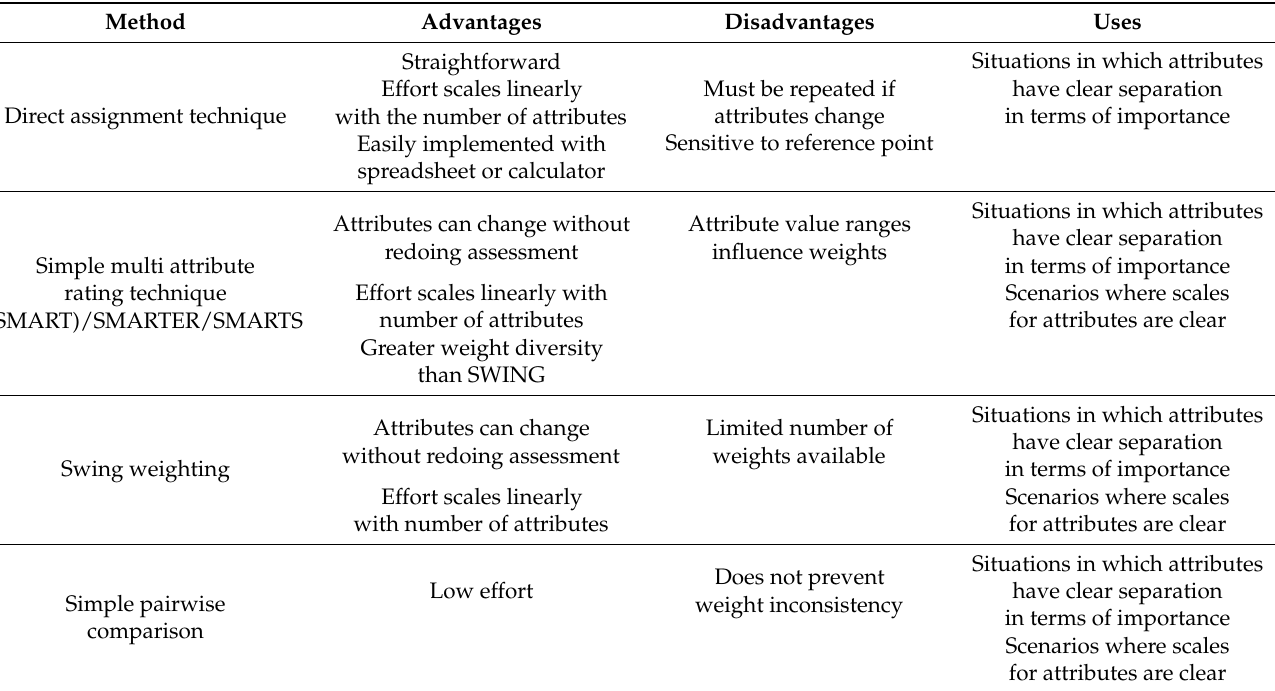
Table 16. Characteristics of weighting methods for ratio assignment techniques.